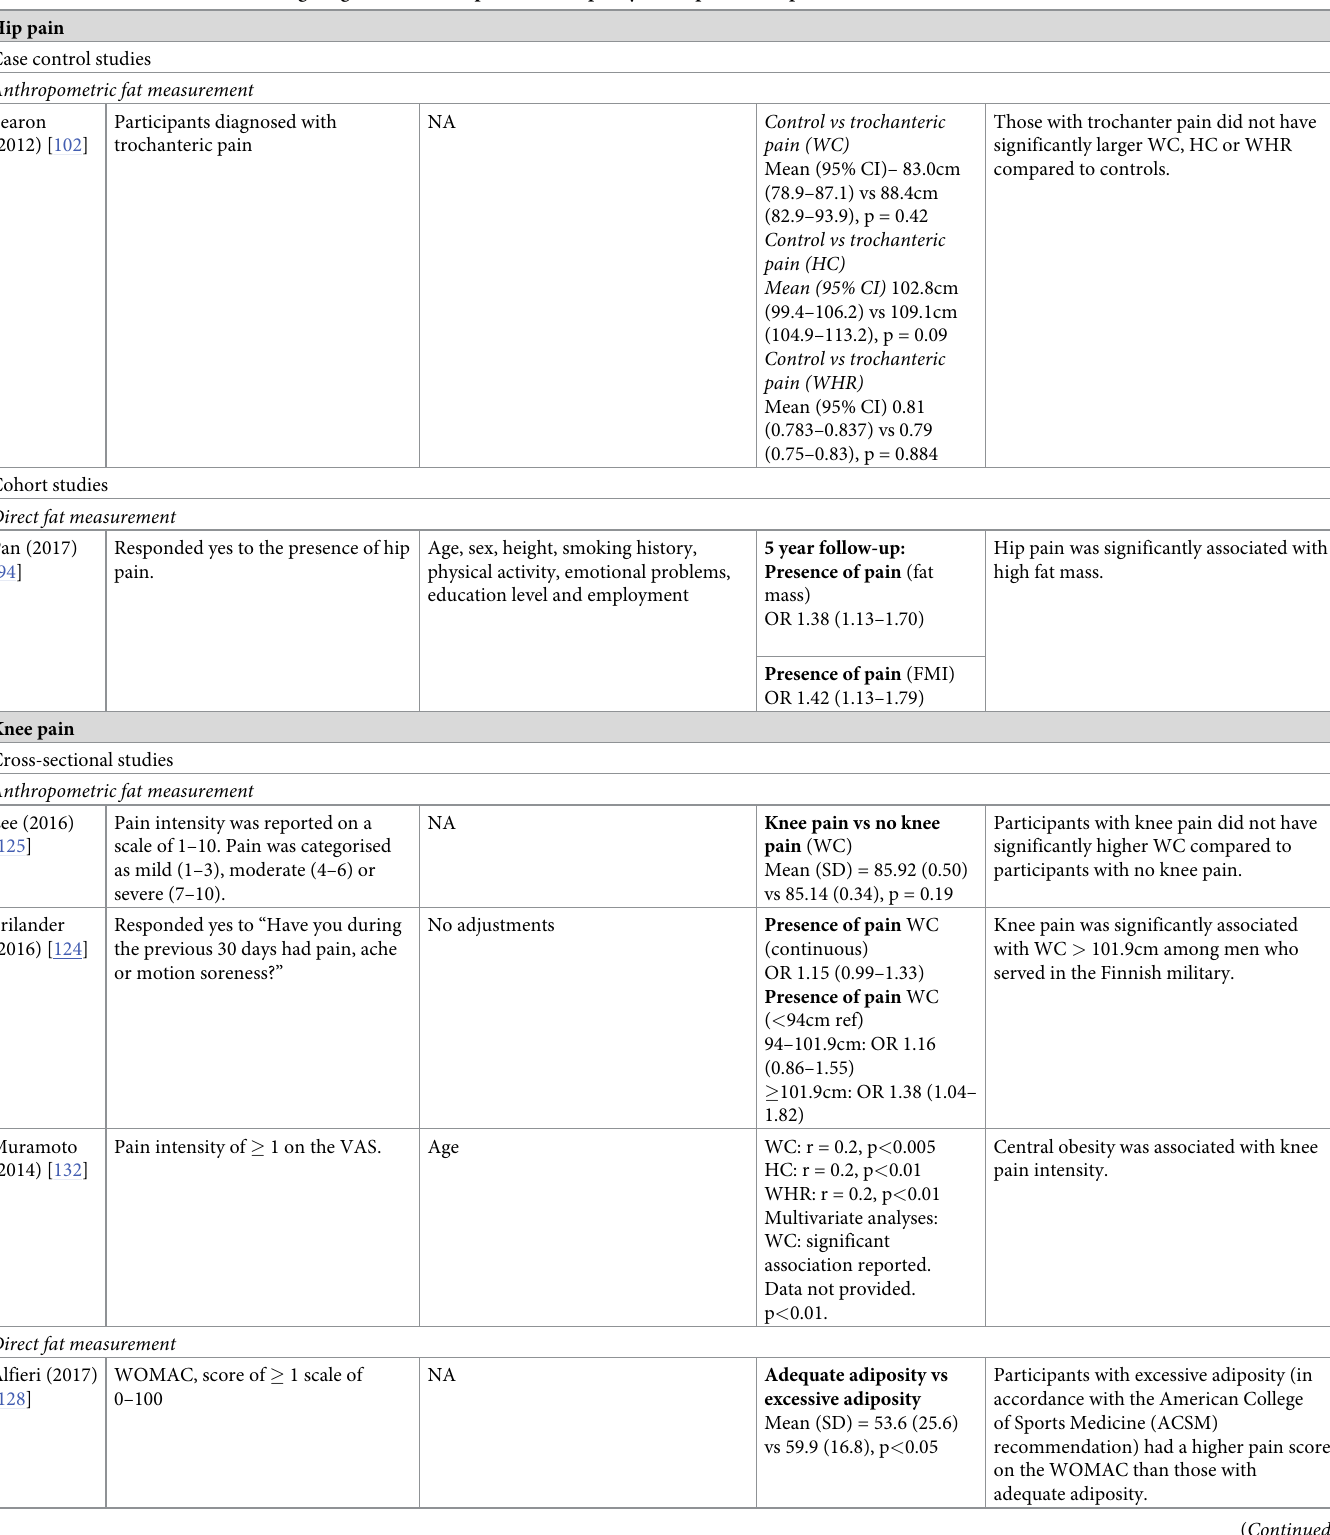
Table 5. Results of the studies investigating the relationship between adiposity and hip and knee